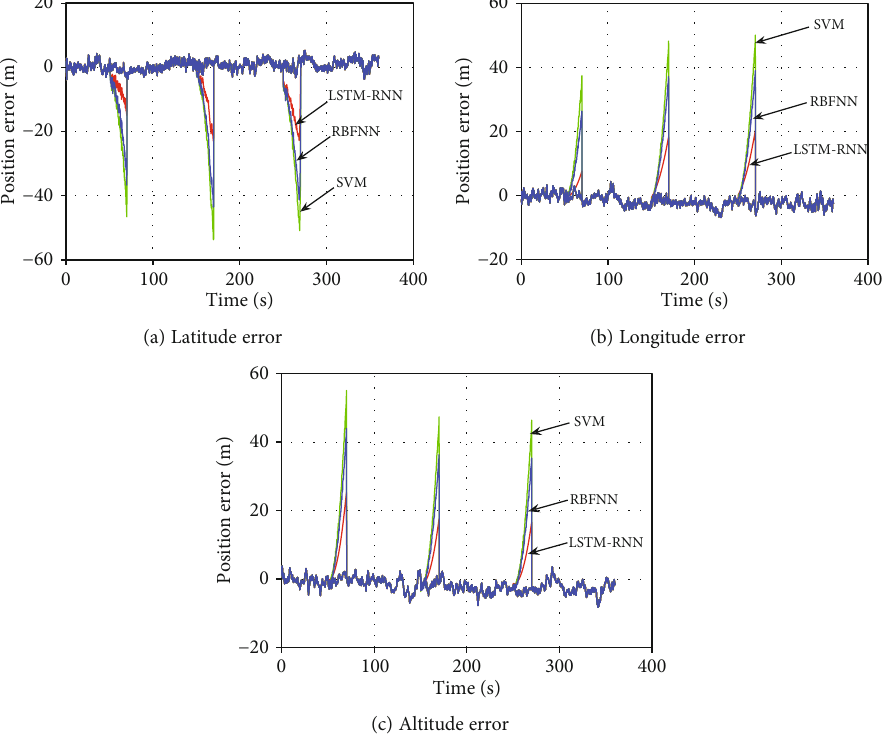
Figure 12: Position errors (no available satellites).